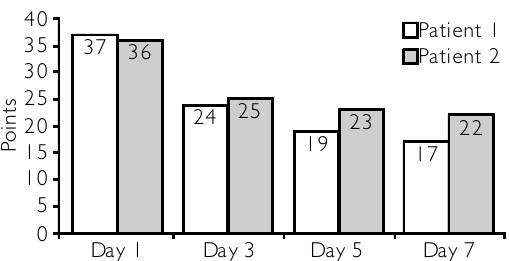
Figure 2 Course of Acute Physiology and Chronic Health Evaluation (APACHE) II scores